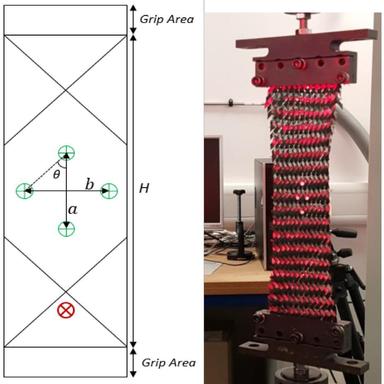
Schematic and actual specimen with experimental shear angle measurement in the pure shear zone of BE test.